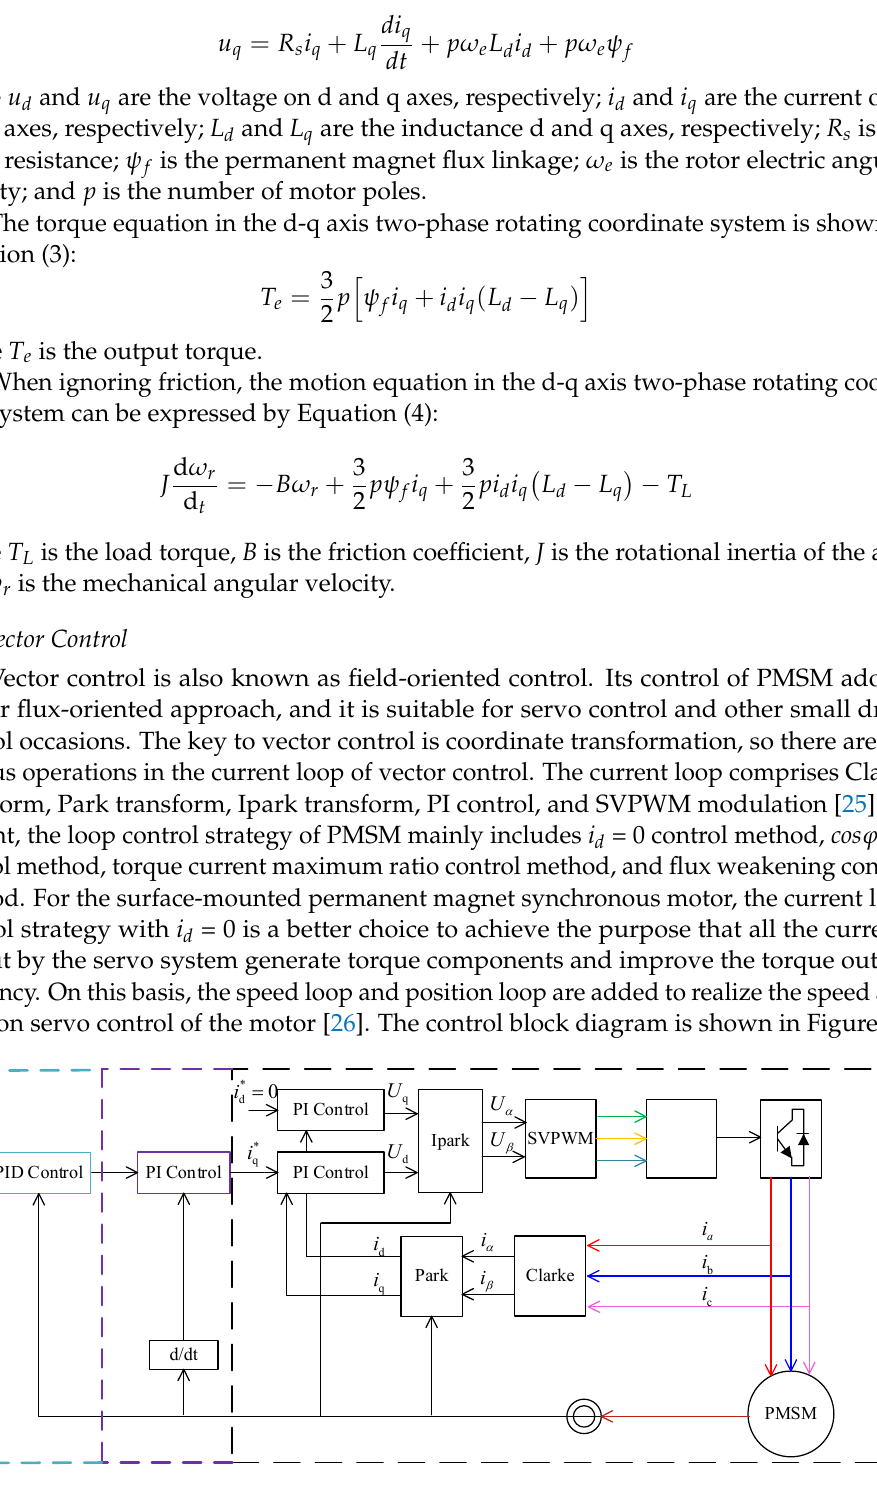
Figure 2. PMSM position servo control system.